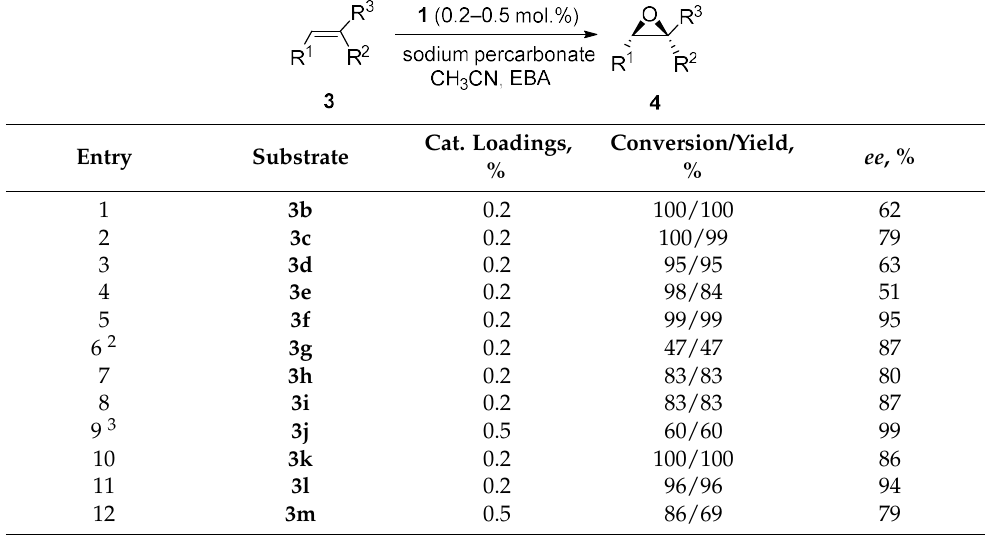
Figure 2. Olefinic substrates studied in manganese catalyzed epoxidation with sodium percarbonate. Table 2. Asymmetric epoxidation of olefins with sodium percarbonate in the presence of 1 1 .